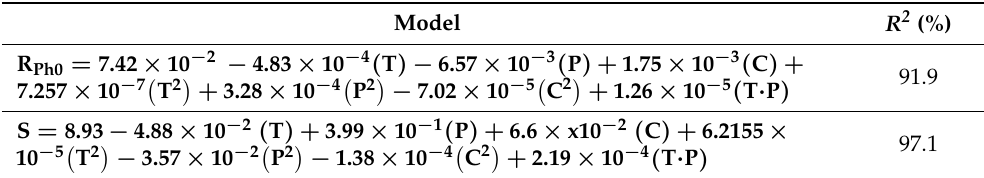
Table 2. Statistical model. Responses: Initial reaction rate of phenol R Ph0 and selectivity and Factors: Temperature (T, ◦ C), Pressure (P, MPa) and Mo loading (C, wt.%) and their respective correlation Table 3. Analysis of variance (ANOVA) for second-order models (95% probability).